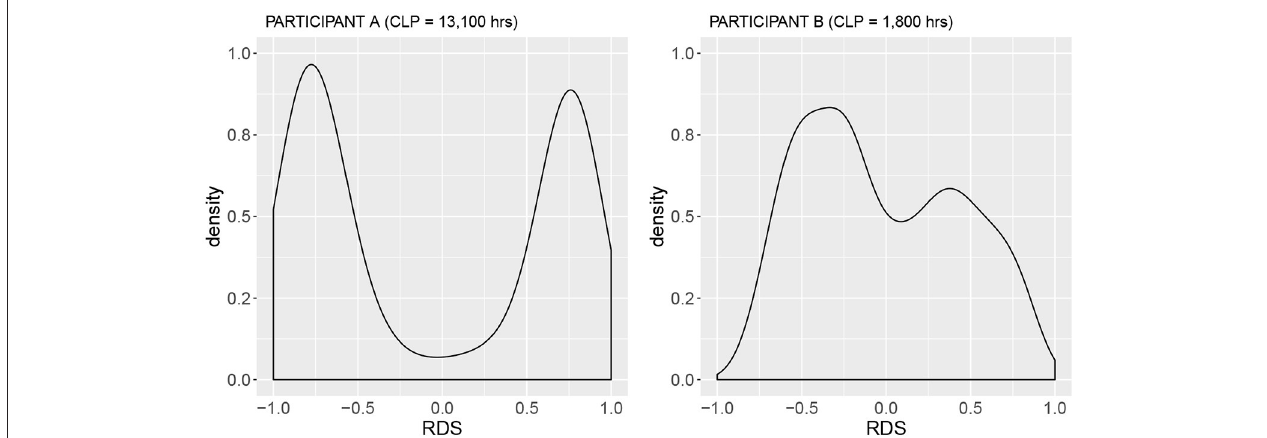
FIGURE 3 | Density plots of the RDS signal for Participant A, Cumulative Lifetime Practice, CLP = 13,100 h, sdRDS = 0.74 and Participant B, Cumulative Lifetime Practice, CLP = 1,800 h) sdRDS =0.46. RDS signals from both plots were derived from the single right-hand only exercise (RHSolo) at 400 HPM (see Figure 2 ). Note the bi-modal distribution of Participant A, that accounts for the large standard deviation ( sdRDS